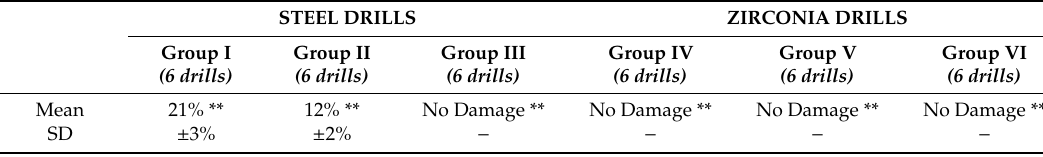
Table 1. Summary of the drills’ surface area damaged by the testing processes. The disinfection processes generated significant surface corrosion compared to the zirconia drills ( p < 0.01). The autoclave sterilization did not cause any alteration to the different drill surfaces.